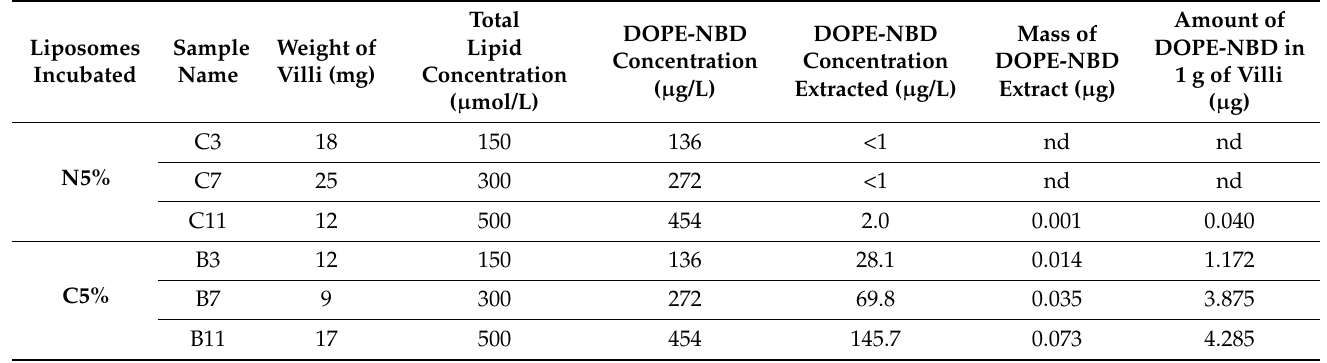
Table 2. DOPE-NBD quantification in placental tissue after incubation with neutral and cationic liposomes at various concentrations. The amount of DOPE-NBD is normalized to their